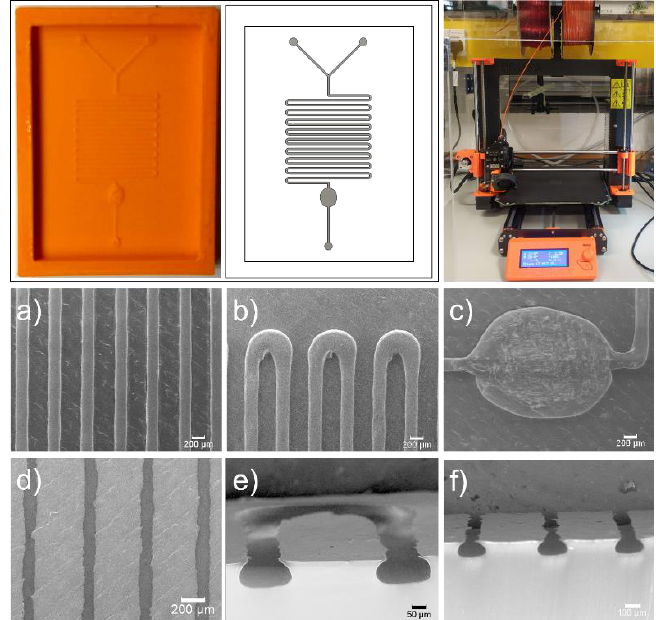
Figure 3. Example device in acrylonitrile butadiene styrene (ABS), with corresponding design and photo of the Prusa i3 MK3 equipped with 0.2 mm nozzle ( top ) and SEM images of mould (panels a, b and c) and PDMS replica (panels d, e and f) features. ( a ) channel sizing and parallelism; ( b ) e ff ect of curved path on filament deposition; ( c ) e ff ect of multiple concentric lines on round features; ( d ) visibility of ironing path on replicated devices; ( e ) elliptical nature of filament deposition and surface smoothness; ( f ) channel-to-channel